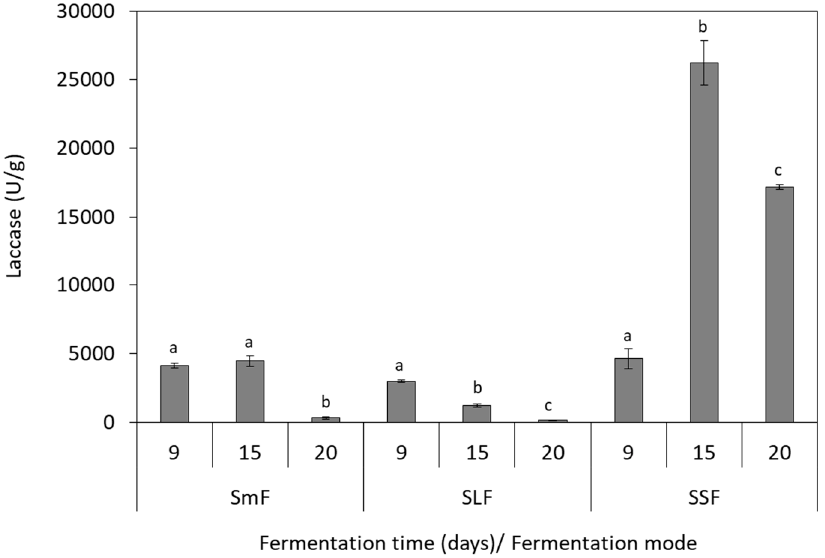
Figure 2. Production of laccase by P. ostreatus during solid-state (SSF), submerged (SmF), and semiliquid (SLF) fermentations using grape pomace as substrate. Different letters indicate significant differences ( p < 0.05) between fermentation days for each fermentation mode.